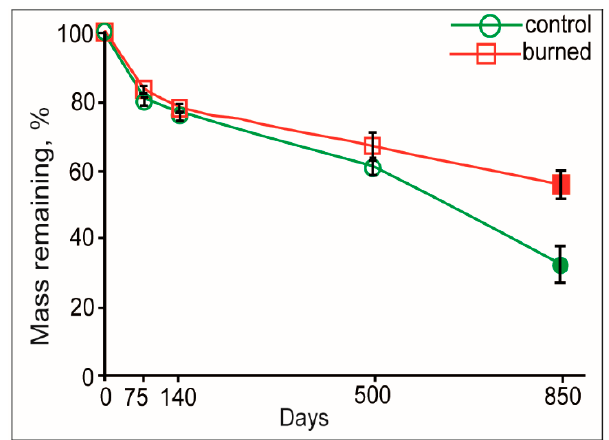
Figure 1. Mass loss of larch needles in burned and control stands. Error bars represent ±SE ( n = 6). Filled markers denote significant differences ( p < 0.05 based on ANOVA followed by Tukey HSD).